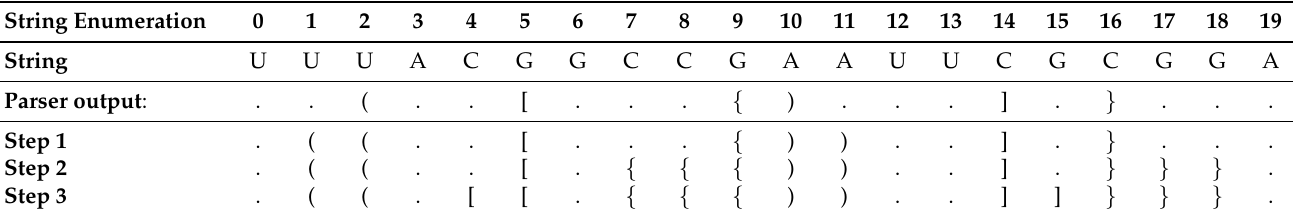
Table 2. Locating base pairs around the core stems of a pseudoknot.